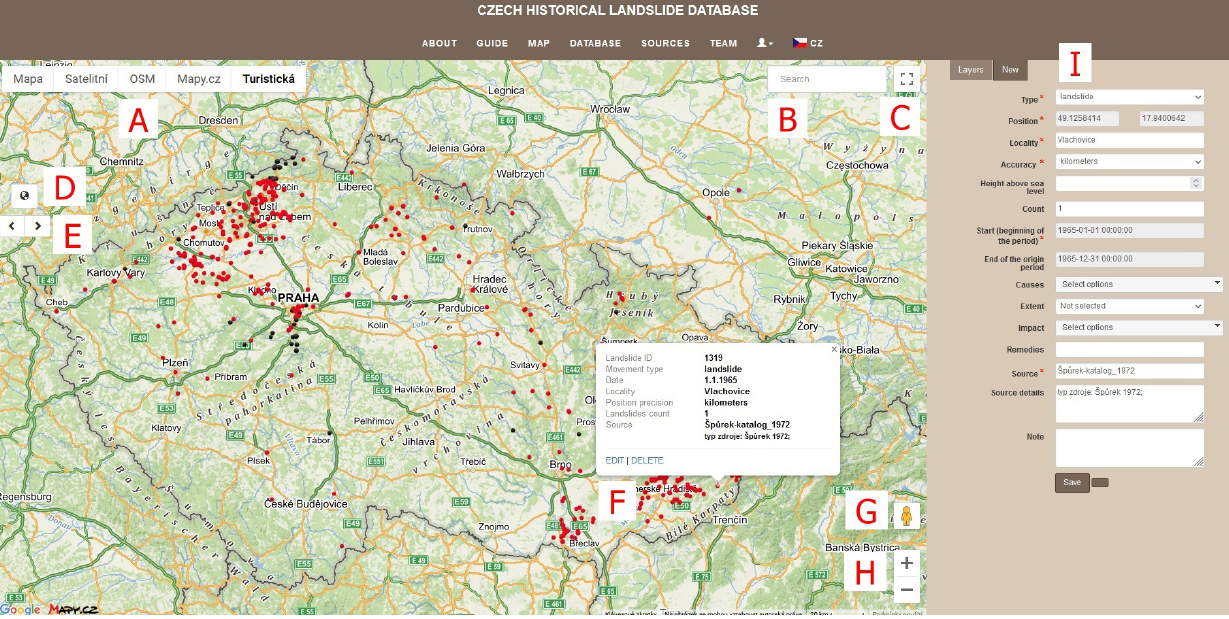
Figure 4. Additional information on a landslide record can be obtained after clicking on a point in the map view. A new landslide can be added through the form (right side). A – background map; B – municipality; C – full-screen mode; D – full extent control; E – backward/forward screen; F – landslide description; G – Google Street View; H – zoom in/out; I – new landslide button.